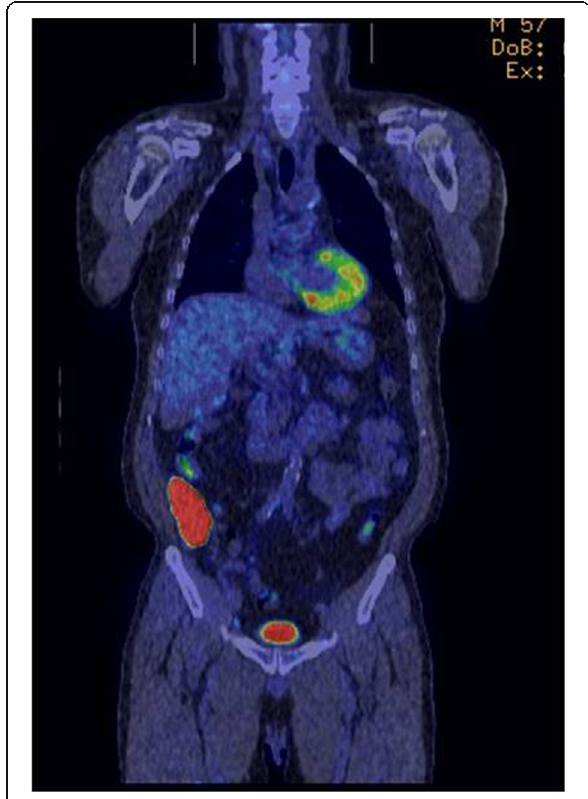
Fig. 4 FDG-PET showing abnormal accumulation (SUVmax 41) in the abdominal wall